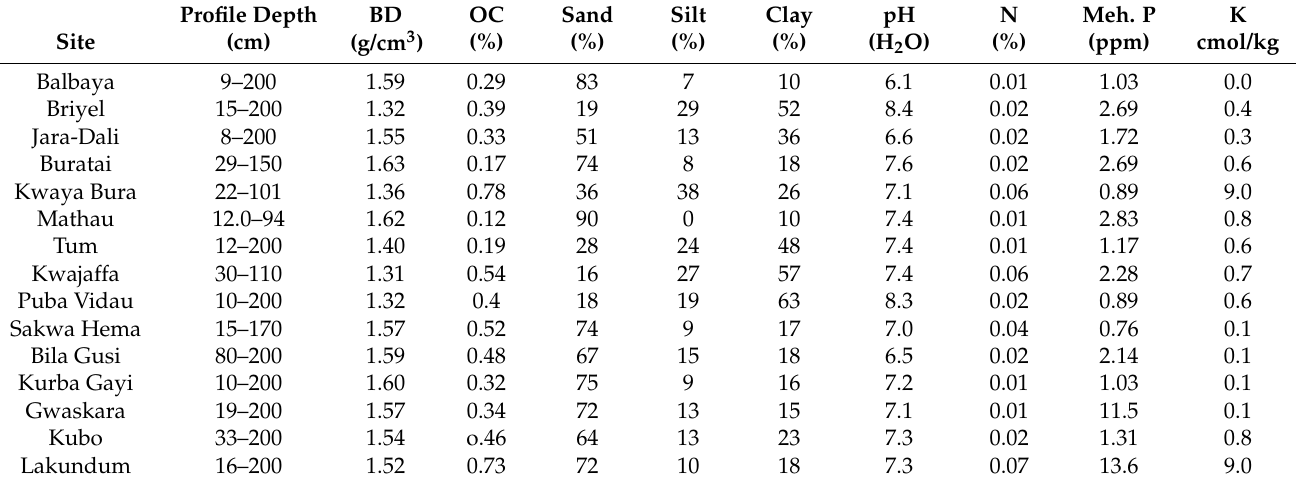
Table 4. Physical and chemical properties used for model applications in Borno